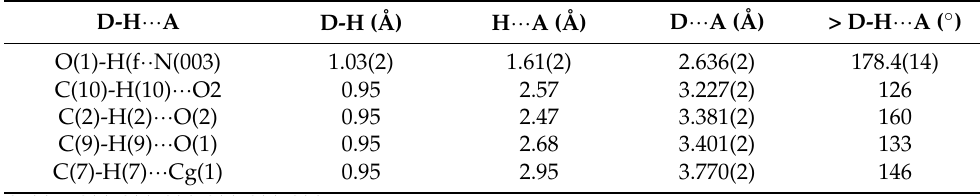
Table 3. Selected supramolecular interactions for cocrystal 2